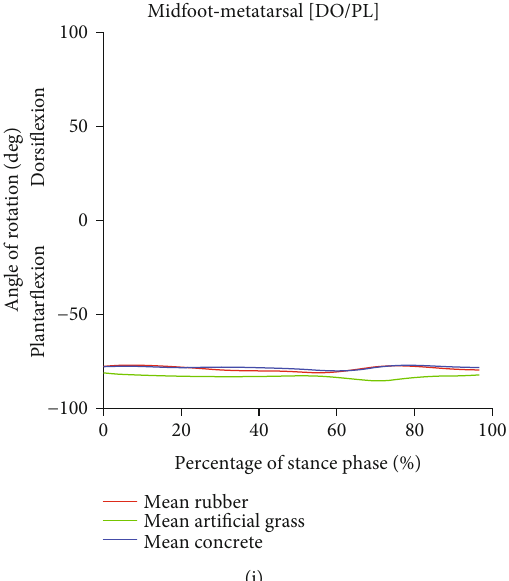
Figure 6: Angle of joint rotation in the foot segment of minimal shoe (MS) running: (a) calcaneus-metatarsal (eversion/inversion), (b) calcaneus-metatarsal (abduction/adduction), (c) calcaneus-metatarsal (plantar/dorsi fl exion), (d) calcaneus midfoot (eversion/inversion), (e) calcaneus-midfoot (abduction/adduction), (f) calcaneus-midfoot (plantar/dorsi fl exion), (g) midfoot-metatarsal (eversion/inversion), (h) midfoot-metatarsal (abduction/adduction), and (i) midfoot-metatarsal (plantar/dorsi fl exion). Table 1: Joint rotation during midstance of HS running.